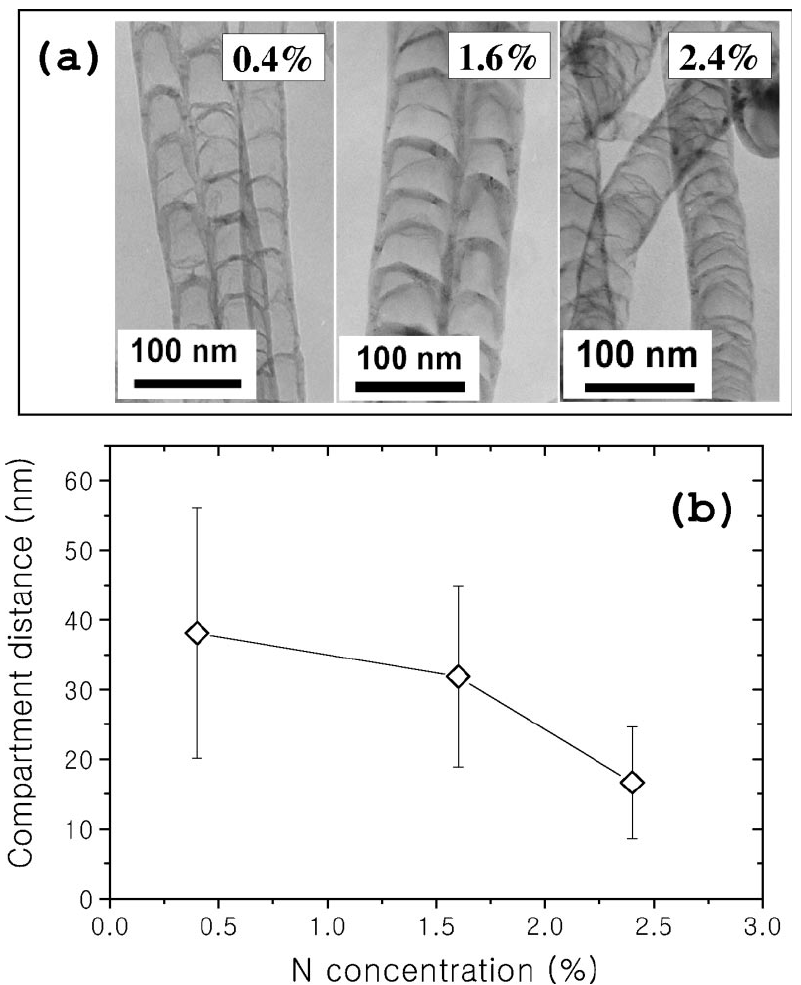
Figure 4. The compartment structures for various nitrogen concentrations. (a) The TEM images of compartment layers of CN x nanotubes. (b) The compartment distance as a flow ratios of 30, 90, and 150 mL/min function of the nitrogen concentration. The NH 3 gave N-CNTs with N doping levels of 0.4%, 1.6%, and 2.4%. (Jang, J.W.; Lee, C.E.;